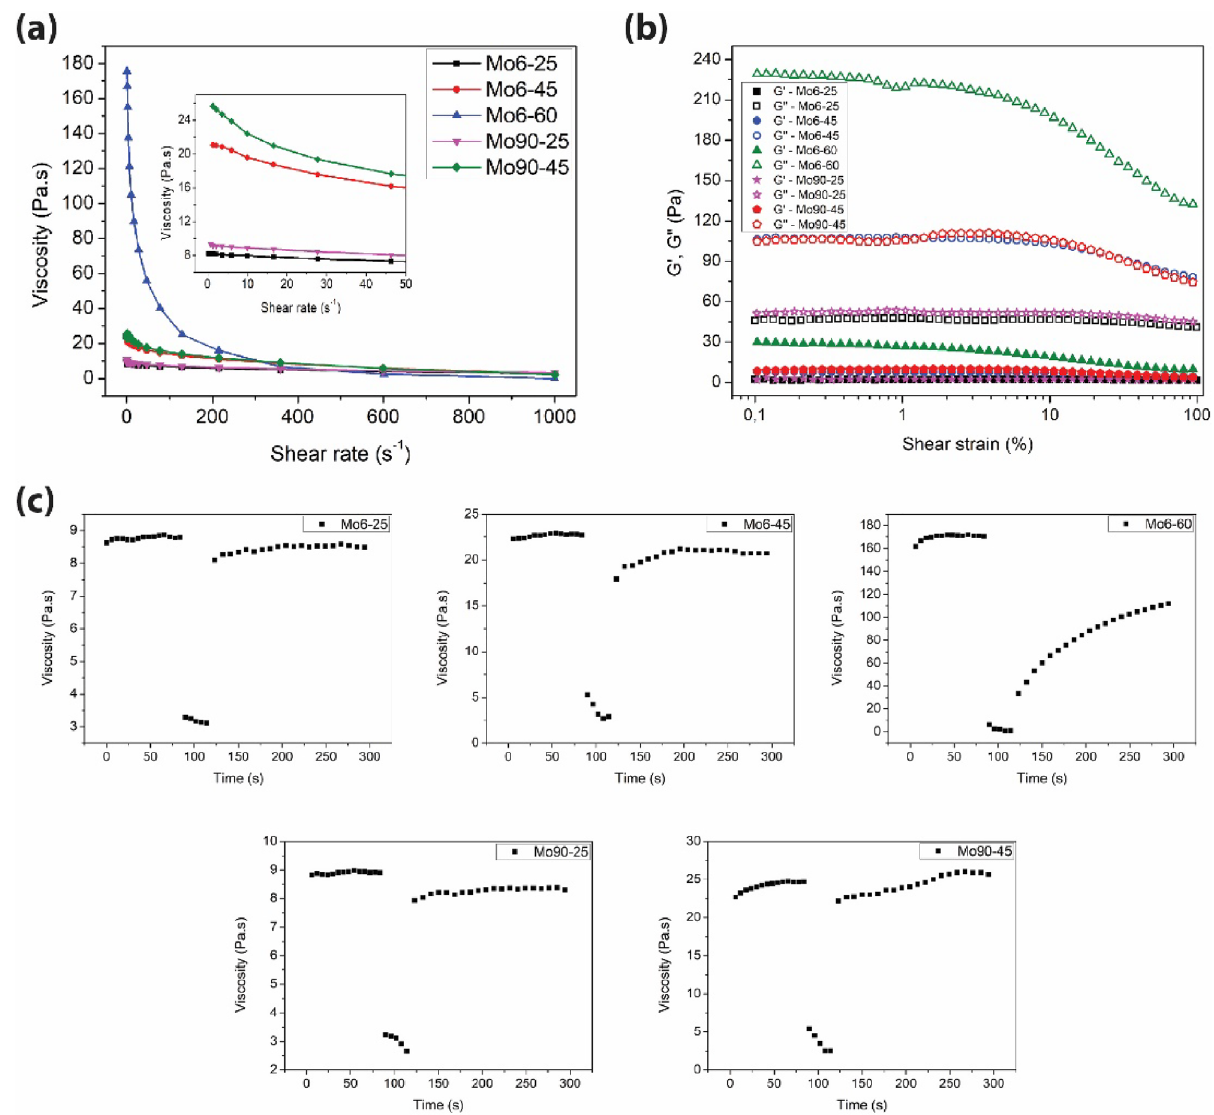
Figure 1. ( a ) Dynamic viscosity of screen-printable MoS 2 inks at shear rates ranging from 0.01 to 1,000 s -1 . ( b ) Shear strain sweep of MoS 2 inks. ( c ) Rheological behavior of MoS 2 inks during simulation of screen-printing.